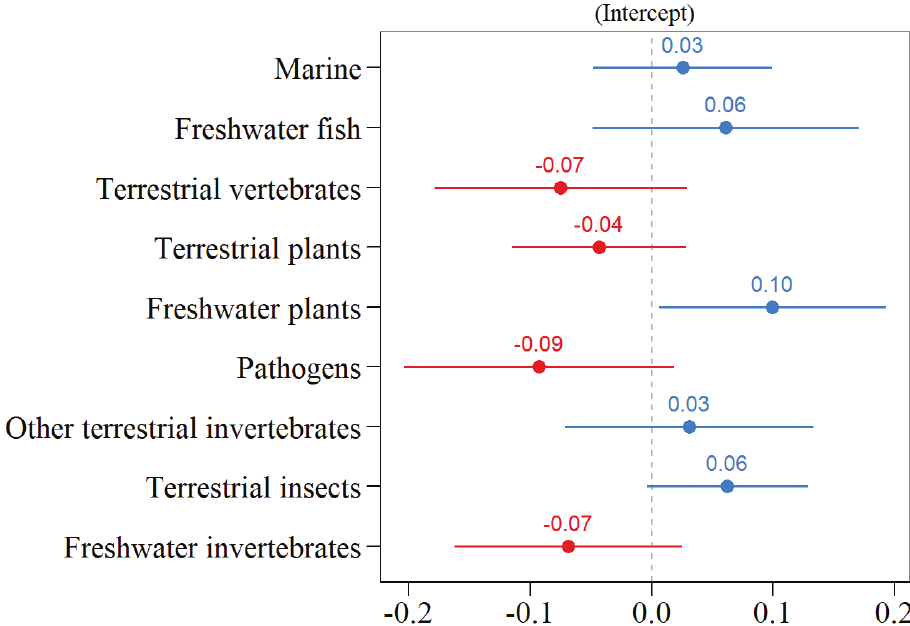
Figure 2. Mean regression coefficient and confidence interval (95%) of taxonomic groups (random effects) in the best linear mixed model explaining the coefficient of variation of scores of 57 invasive non-native species for 11 different protocols including all significant species, assessor and protocol characteristics (see Table 2)